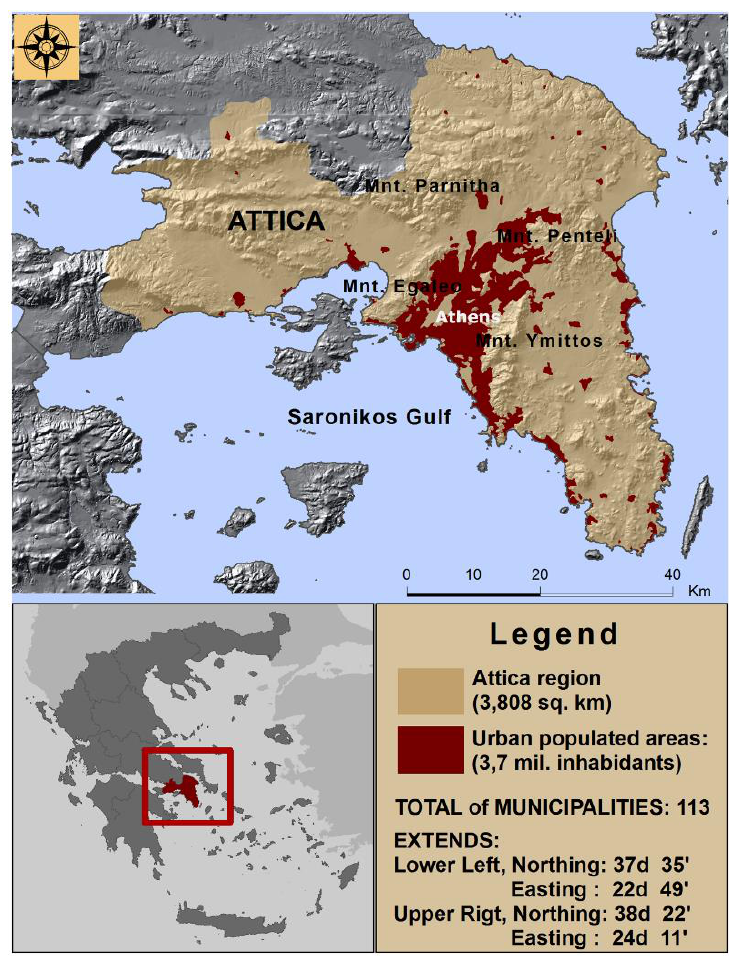
Figure 1. The study area (Source of Geographical Data: DCW 1:1M, ESRI TM ).